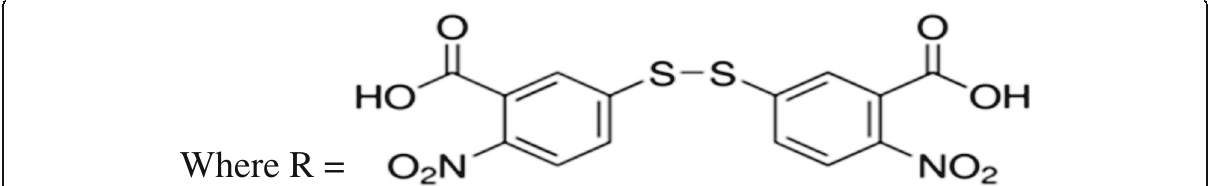
Fig. 3 Hydrolysis of thiocholine with DTNB to produce 5-thio-2-nitrobenzene